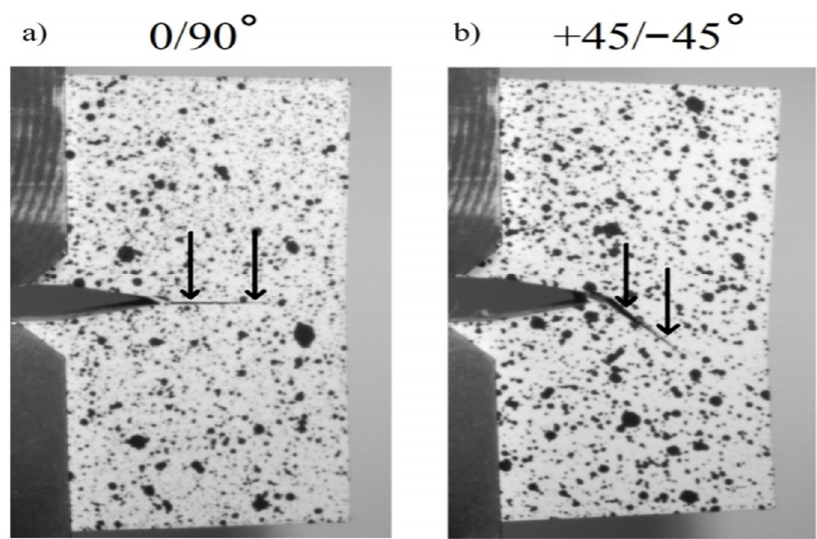
Figure 10. Crack propagation for the XYZ orientation containing a Y-X crack. ( a ) The in-plane crack propagation of the 0/90° samples is denoted by the black arrows. ( b ) The out-of-plane crack propagation at a 45° angle in the +45/ − 45° sample is denoted by the black arrows. Reprinted with permission from Ref. [85]. 2017, Elsevier.